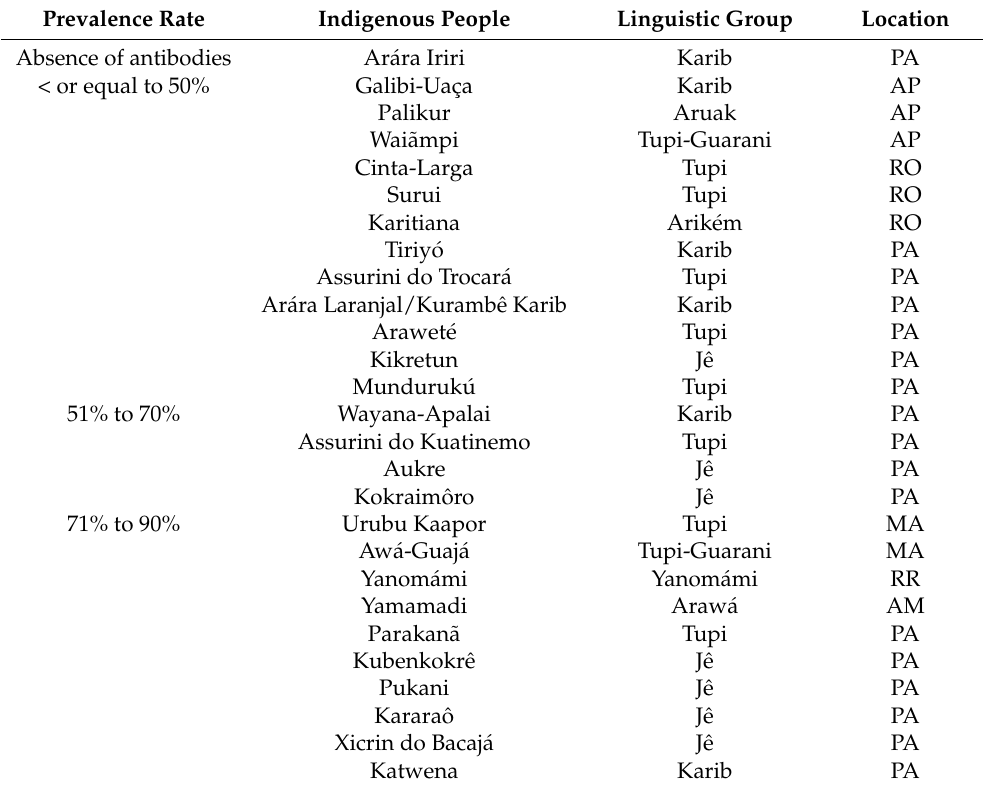
Table 1. Prevalence range of antibodies (IgG) to the genus Chlamydia among indigenous peoples from the Amazon region of